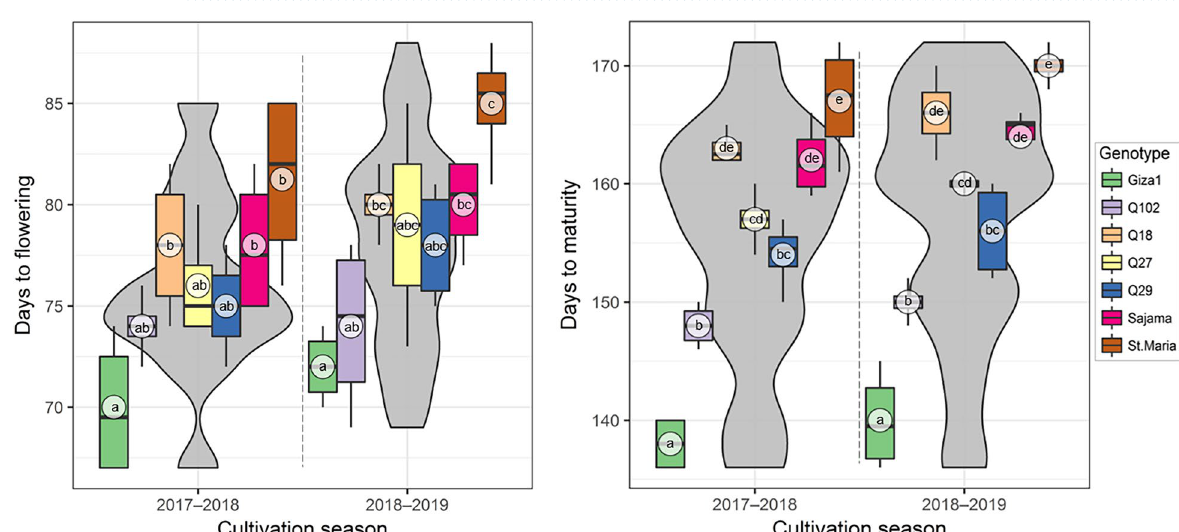
Figure 2. Boxplots showing the variation of plant height and number of panicles during two cultivation seasons for different quinoa ( Chenopodium quinoa ) genotypes grown in open field under hot-arid conditions. The same letters associated with mean values (white circles) are significantly not different ( p > 0.05) following Tukey’s post- hoc test, with data of each cultivation season was tested separately.